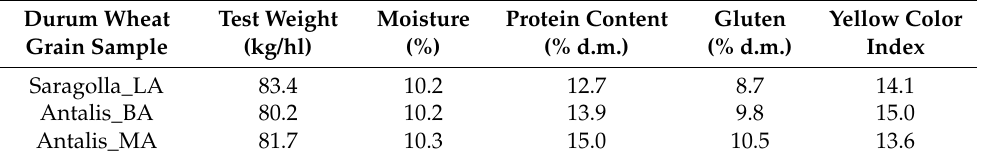
Table 1. Infratec ™ analysis: test weight, moisture, protein content, gluten and yellow color of durum wheat grain samples Saragolla_LA, Antalis_BA, Antalis_MA. Results indicate mean values of replicated analyses ( n = 10); d.m. = dry matter.